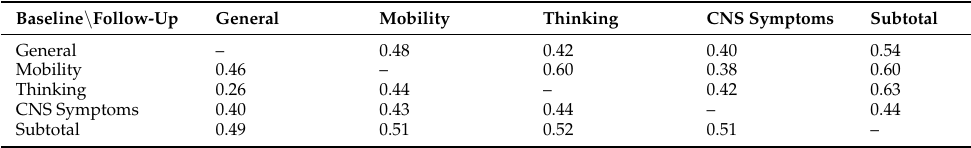
Table 4. Inter-scale correlations.